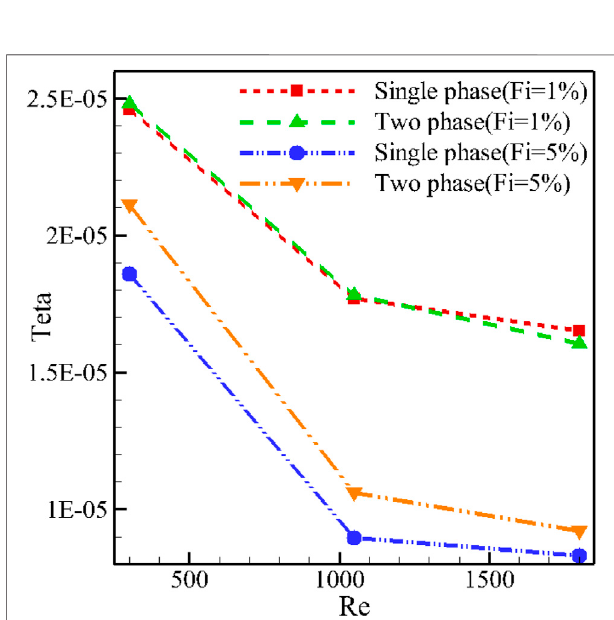
FIGURE7| Temperature uniformityattheH-Sbottomatdifferentvalues of Re when φ (cid:1) 2% for the T-P and S-P simulation